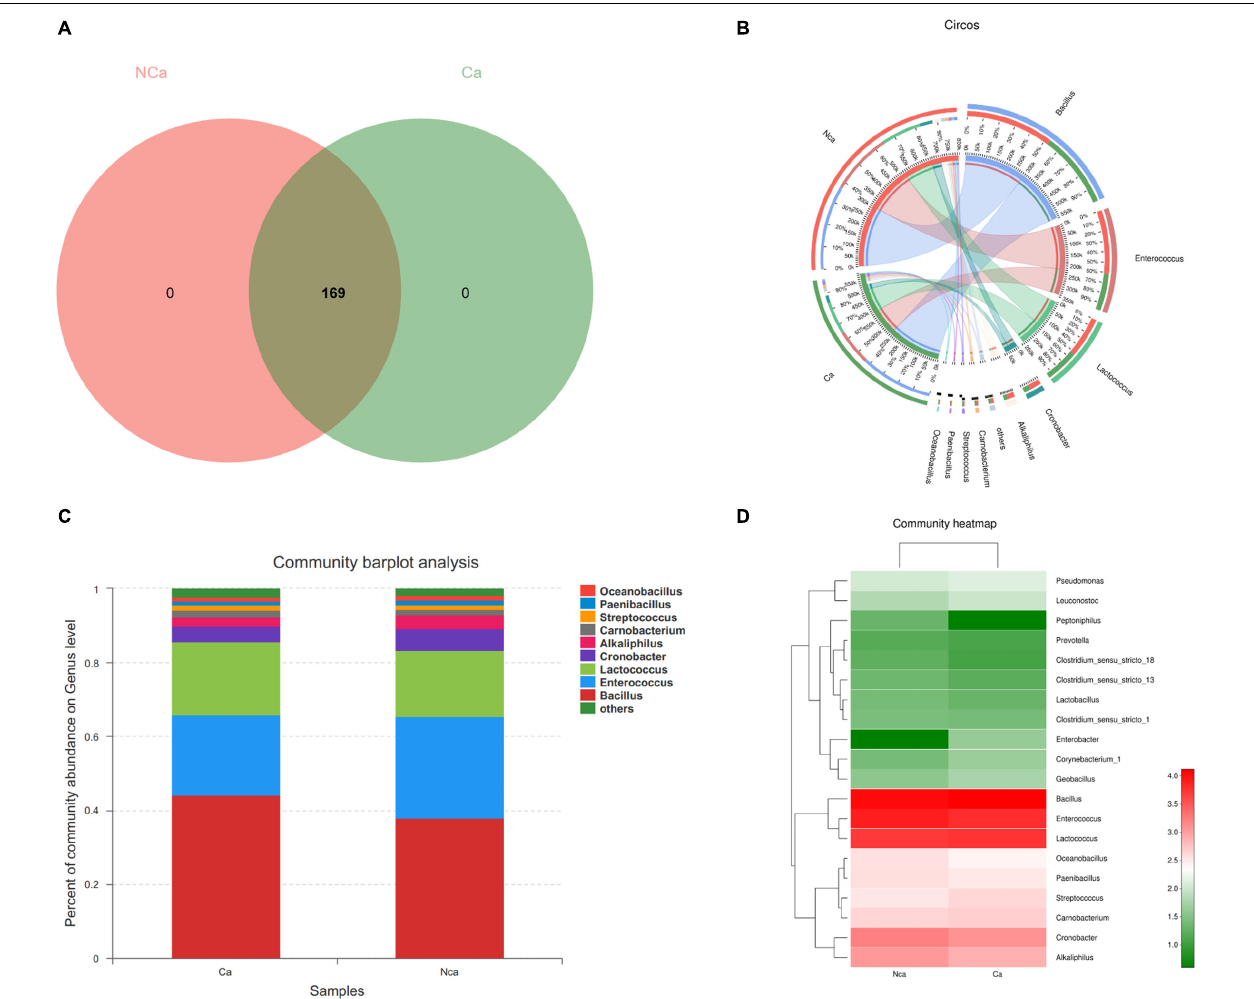
FIGURE 4 | Species composition analysis. (A) The two groups did not show a specific composition. (B) The community pie chart shows the microbial composition of the two groups. (C) The community barplot for the two groups. (D) The heatmap demonstrates the compositions of the two